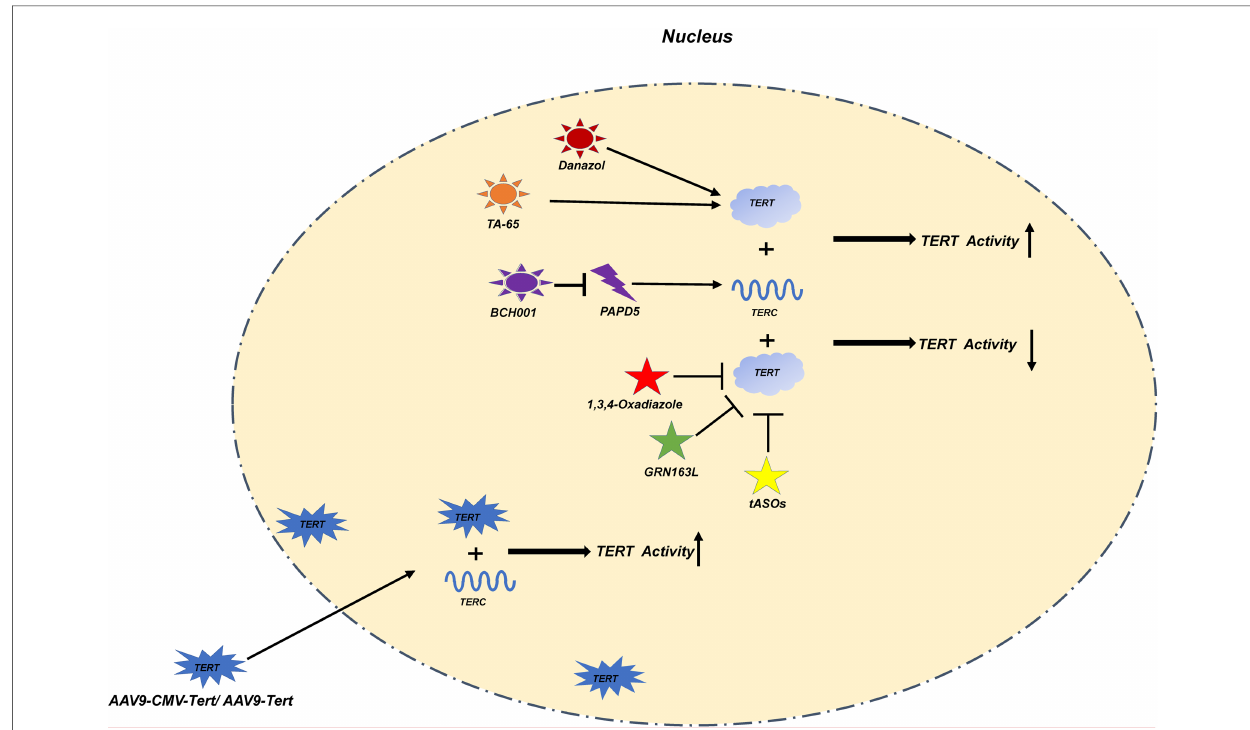
FIGURE 3 In this fi gure, we show various treatment methods and their mechanisms in detail. Danazol, TA-65 directly increase the activity of TERT; BCH001 reduces the consumption of TERC by inhibiting PAPD5 to improve the activity of TERT; The exogenous AAV9-CMV-Tert/AAV9-Tert enhances its activity by increasing the relative number of TERT in the nucleus; 1,3,4-Oxadiazole, GRN163L; ASOs inhibit the activity of TERT.